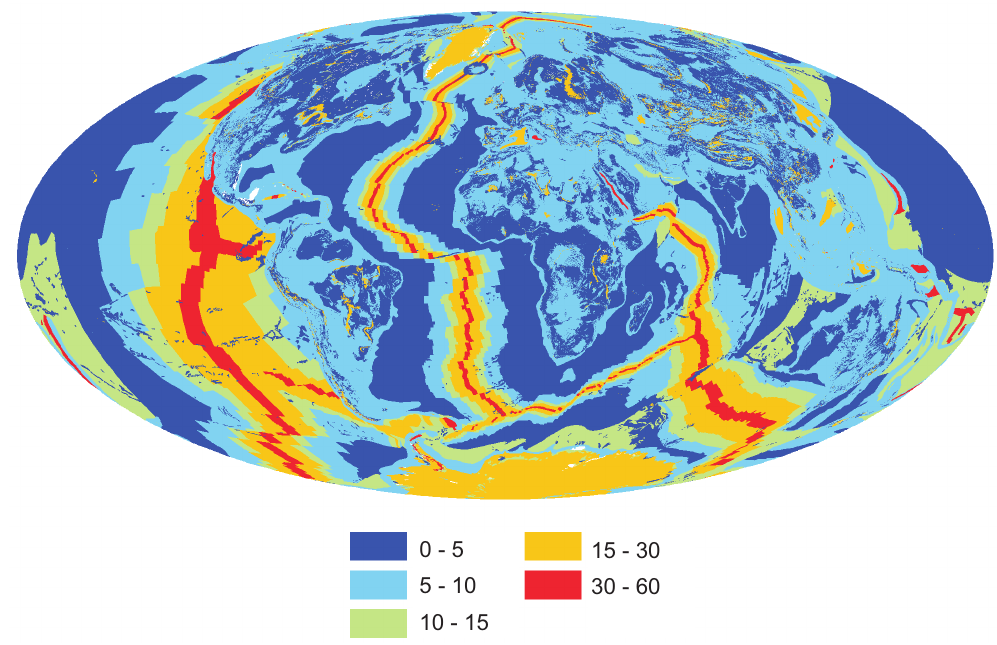
Fig. 11. Map of the estimated error in the preferred global heat flux (mWm − 2 ) . The error is based on the actual spread of heat flow values for each geology category, with the exception of regions where the heat flow value is based on calculation (young oceanic crust) and the Glacier category (for more details see text). The mapped error does not include the component from hot-spots or the uncertainty in the area of geology polygons. We note that the largest error is related to the young oceanic crust and the glacier